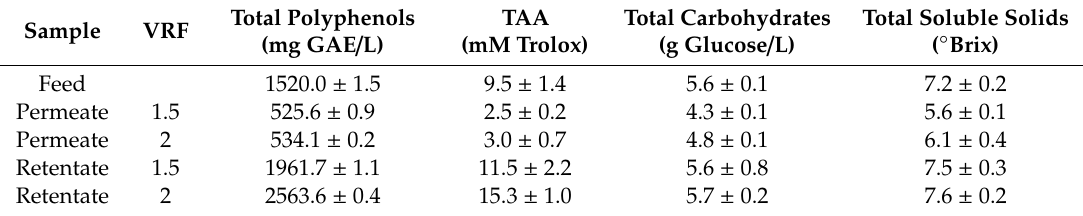
Figure 9. Treatment of clarified aqueous extract with 1 kDa membrane. Time course of permeate flux and VRF (TMP: 8 bar; Q f : 585 L/h; T: 26 ± 1 °C). Table 4. Chemical composition of the aqueous extract before and after the treatment with the 1 kDa membrane.